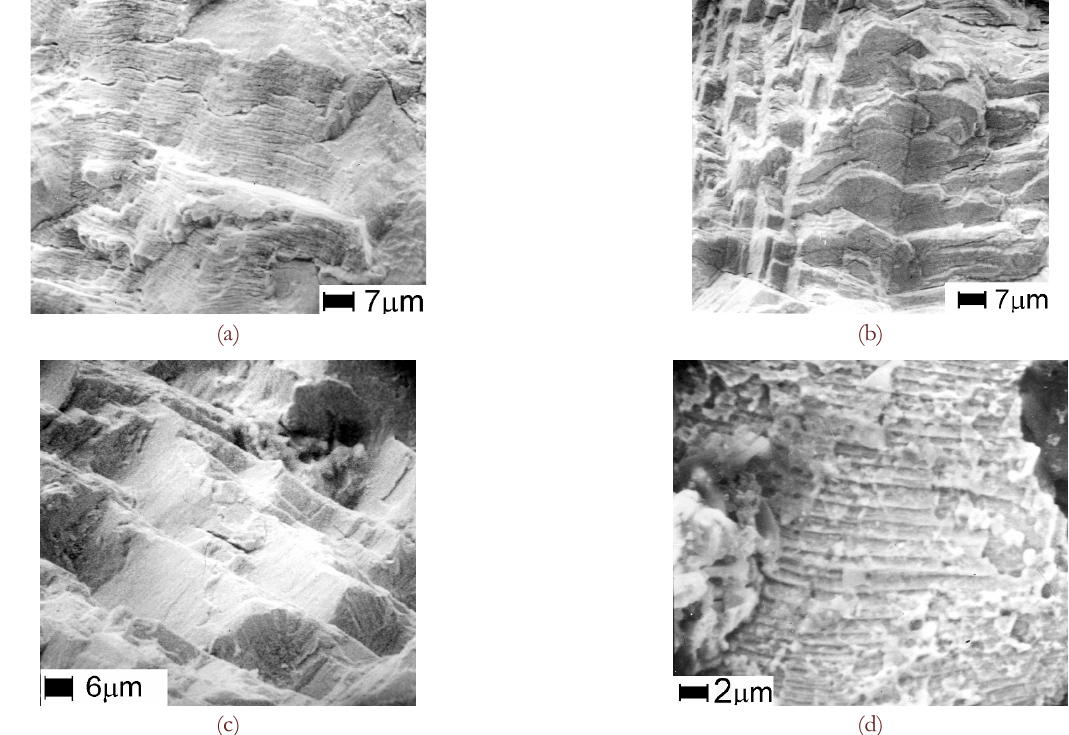
Figure 5: Fracture morphologies of a in-service fatigued turbine disk (a–c) at the stages of (a) early steady and (b, c) accelerated growth of a fatigue crack and (d) by slow in-flight cracking under repeated static loading (see also Fig.